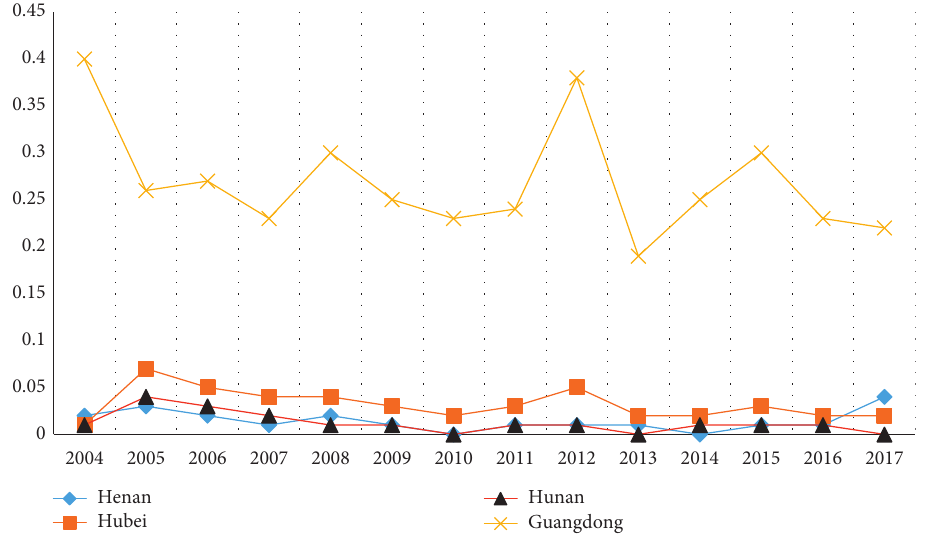
Figure 5: GFI in south China from 2004–2017.